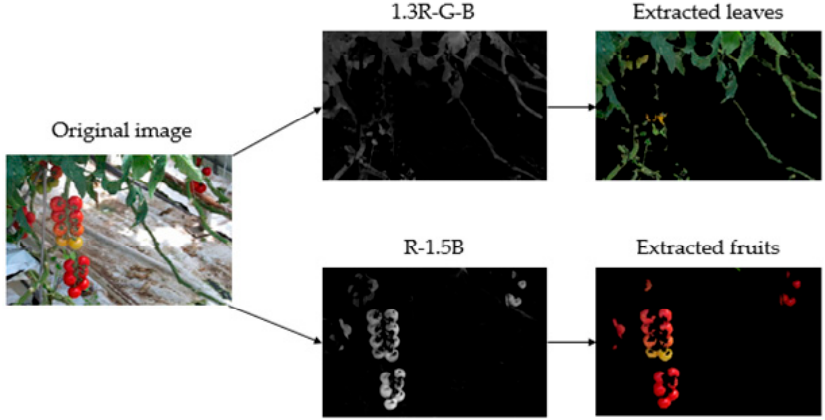
Figure 5. Extraction of tomato organs: algebraic operations in RGB color space.